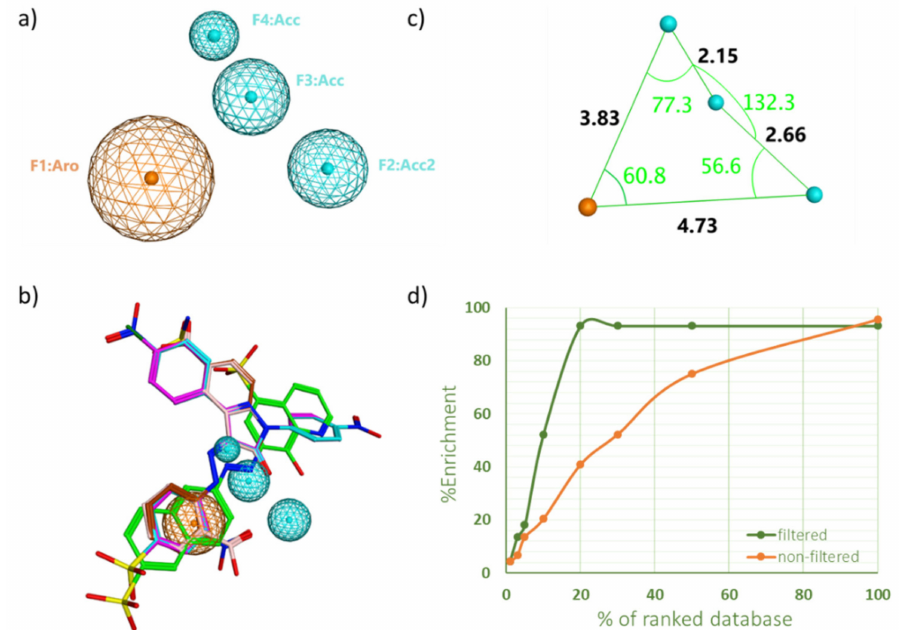
Figure 1. ( a ) The four features of the top pharmacophore query no. 4. ( b ) Two known inhibitors overlaid on the said pharmacophore. ( c ) The measured distances and angles between the four pharmacoohoric features ( d ) The effect of using pharmacophore query no. 4 as pre-docking filter in a pilot showing the number of known SHP2 inhibitors retrieved (%Enrichment) at any given percentage of the top-ranked ligand